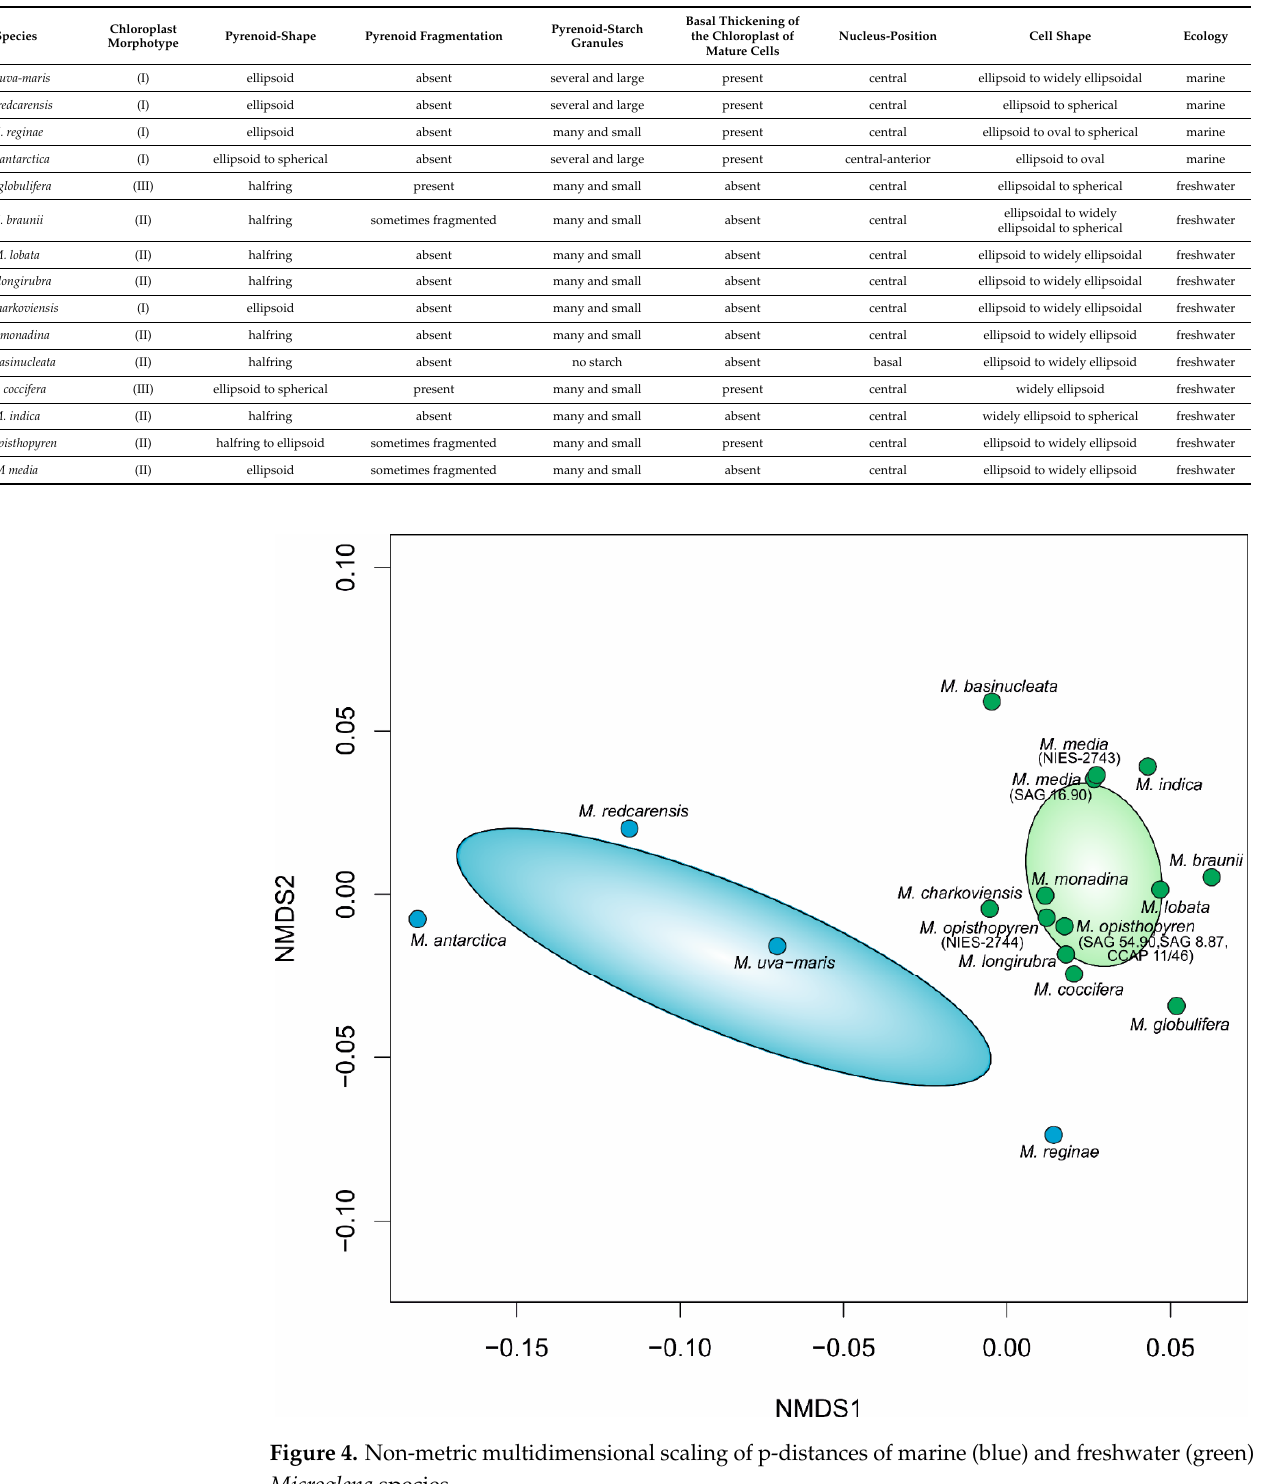
Table 3. Morphological characters and ecology of Microglena species.